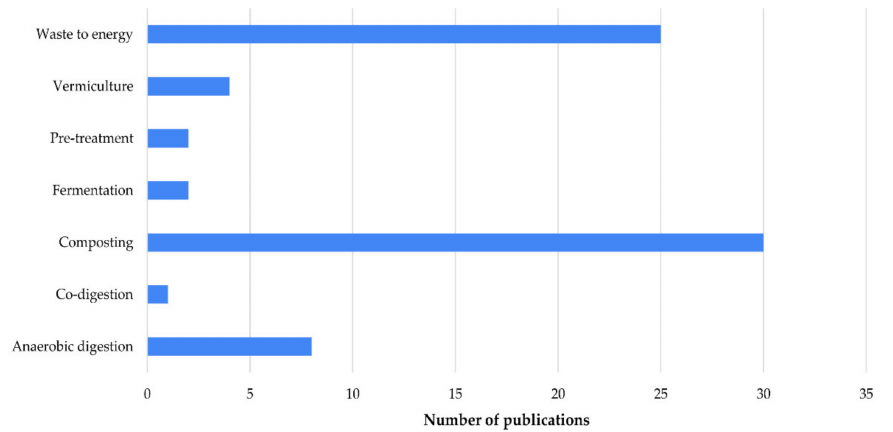
Figure 6. Identified techniques and/or processes for treatment and/or valorization of